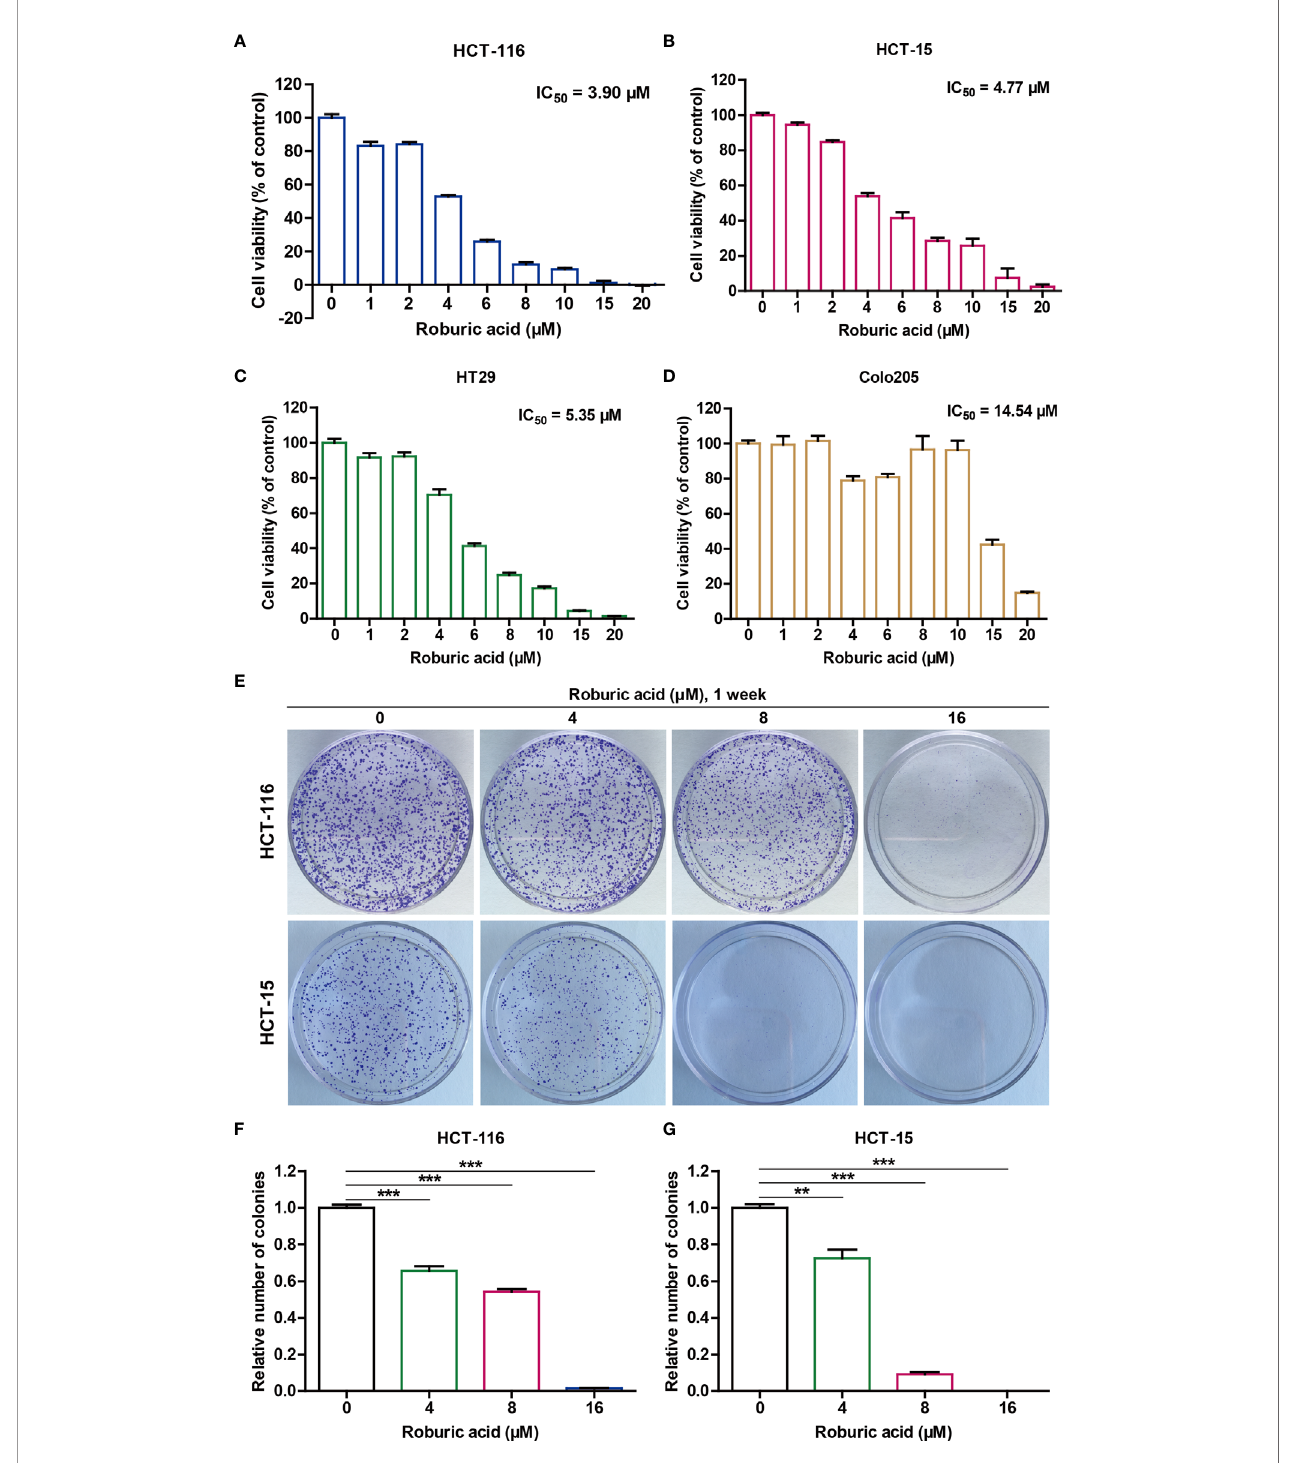
FIGURE 2 | Roburic acid inhibits the viability of human colorectal cancer cells. (A – D) The cytotoxicity of roburic acid against human colorectal cancer cells. HCT- 116 (A) , HCT-15 (B) , HT29 (C) , and Colo205 (D) cells were treated with roburic acid at the indicated concentrations for 48 h. An MTT assay was performed to evaluate cell viability and the IC 50 values were calculated. (E) Flat plate colony formation assay of HCT-116 and HCT-15 cells treated with various concentrations of roburic acid (4, 8, or 16 m M). (F, G) Colony formation rates of the HCT-116 (F) and HCT-15 (G) cells are expressed as fold change. Representative images are displayed. Data are shown as means ± SEM of three independent replicates. ** P < 0.01 and *** P < 0.001 compared with the